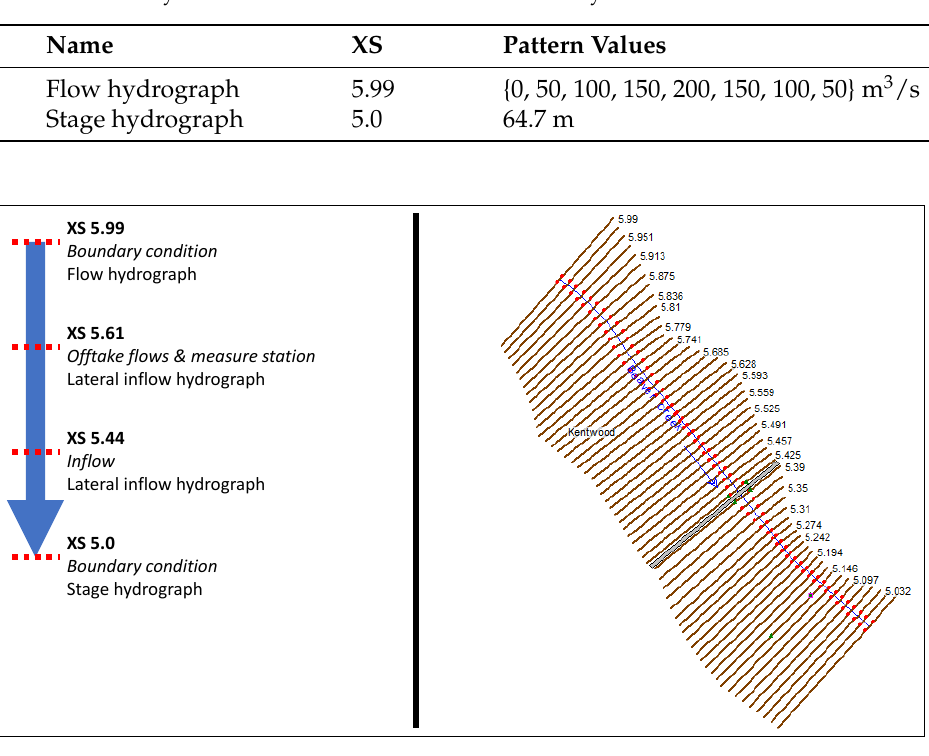
Figure 7. Geometry of the Beaver Creek case